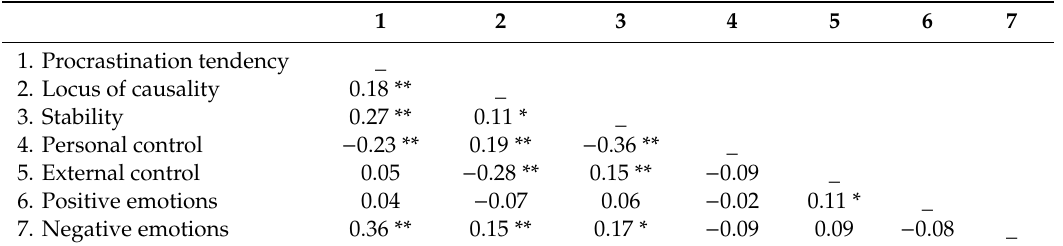
Table 2. Zero-order Correlation among Study Variables.